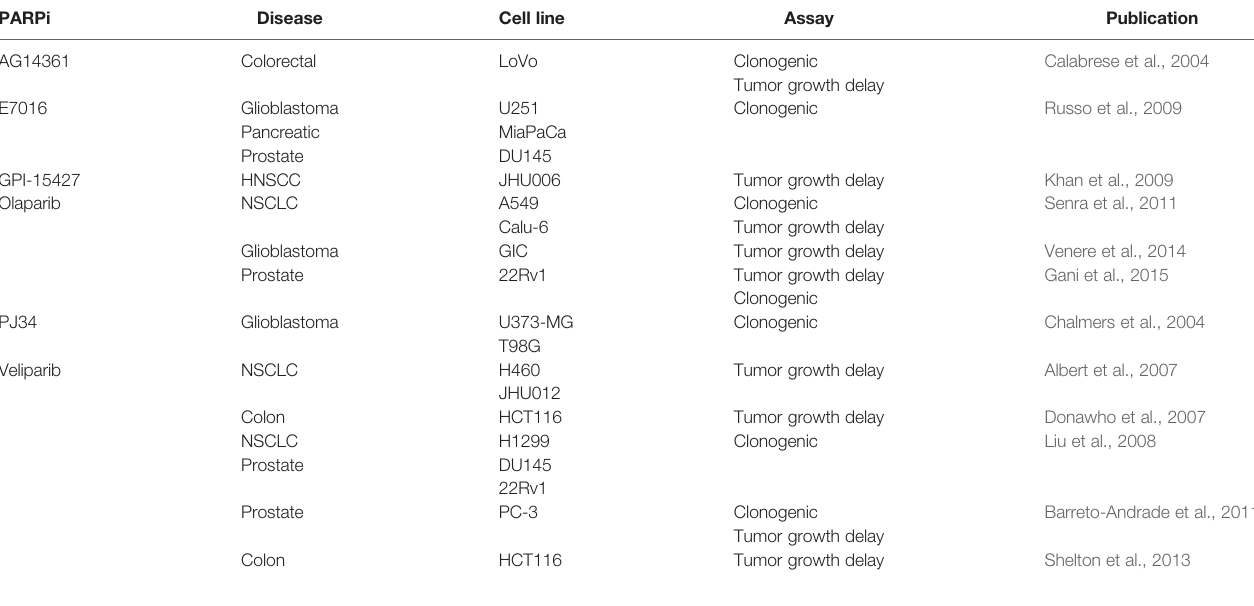
TABLE 1 | Preclinical combination therapies with PARP inhibitors and ionizing radiation. PARPi Disease Cell